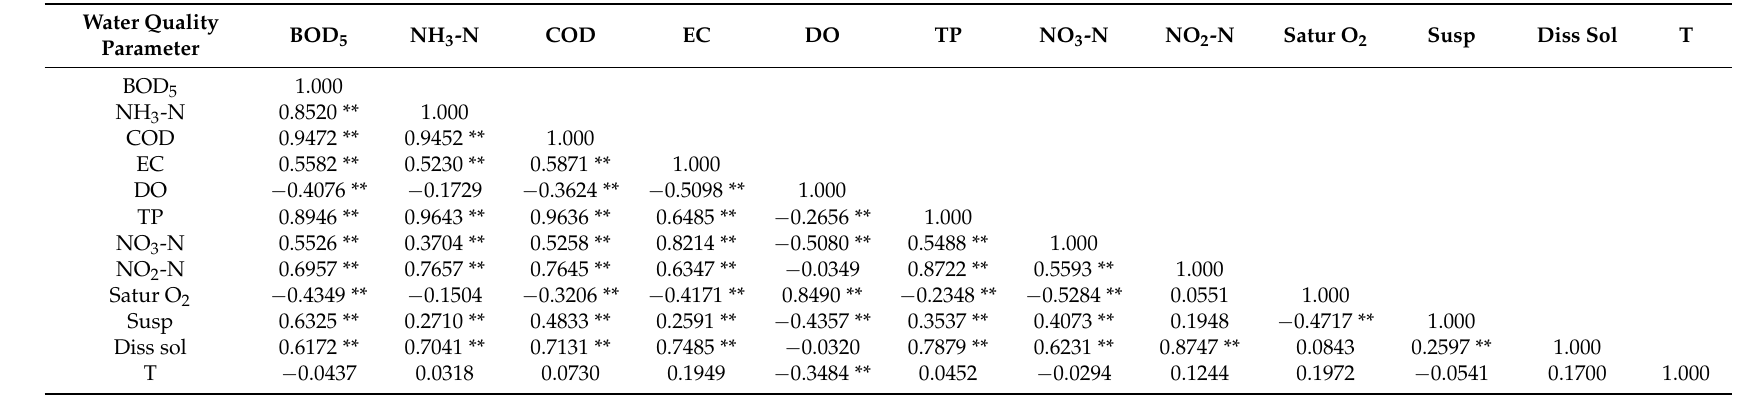
Table 6. Correlation matrix of the weight of the SOM.